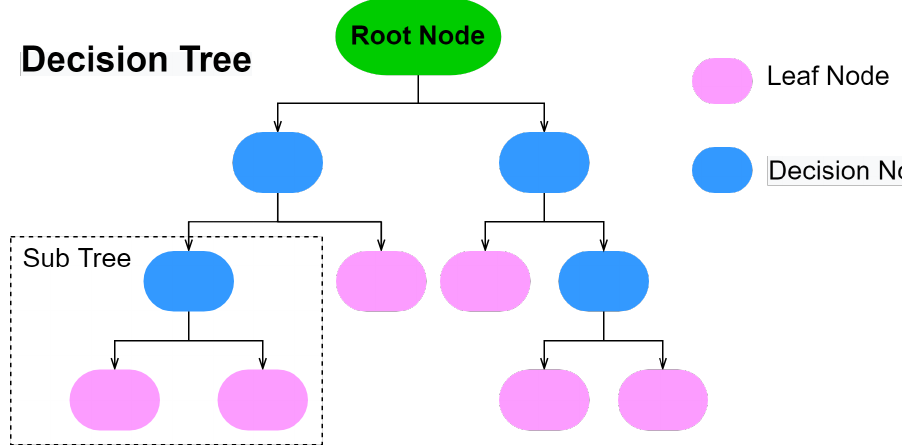
Figure 3. General structure of a decision tree algorithm.